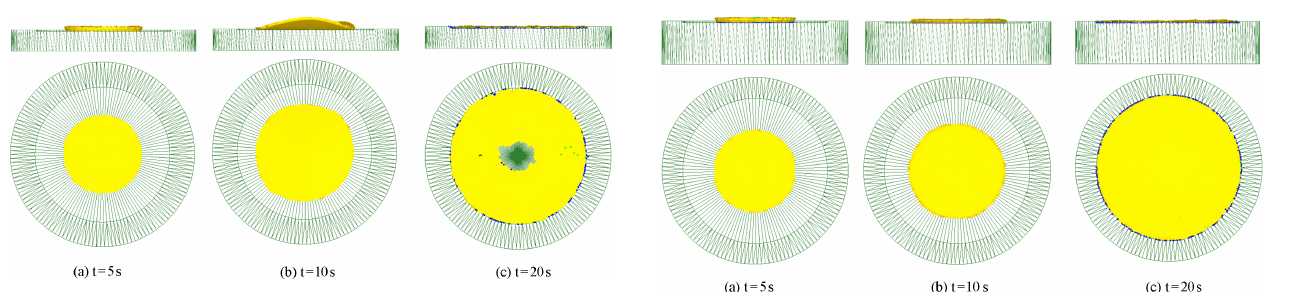
Figure 11. Deformation process of rotary forging with DSRs of a disc under the third deformation